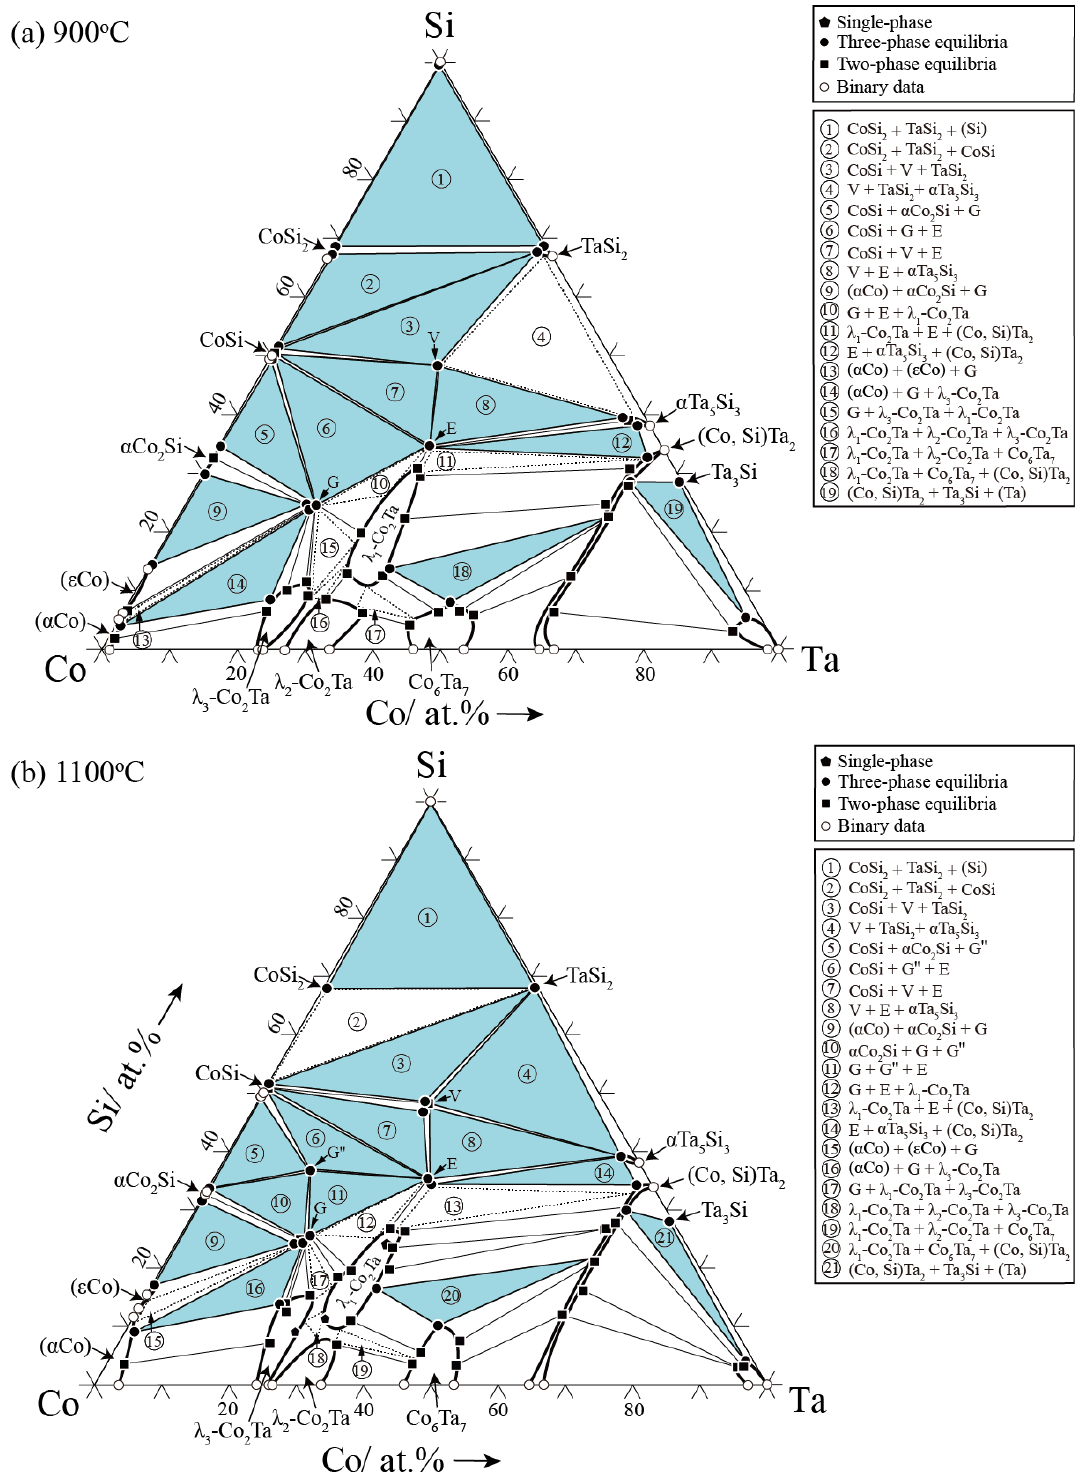
Figure 10. Experimental determined isothermal sections of the Co-Ta-Si system at ( a ) 900 °C and ( b ) 1100 °C. Table 2. Equilibrium compositions of the Co-Ta-Si ternary system at 900 °C determined in the pre- sent work.